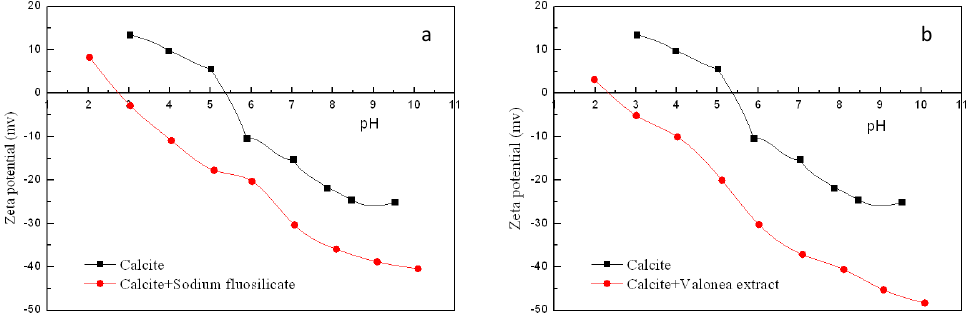
Figure 8. Effect of addition of sodium fluosilicate ( a ) and valonea extract ( b ) on the zeta potential of calcite (sodium fluosilicate dosage = 3 × 10 − 5 mol/L, valonea extract dosage = 4 × 10 − 4 g/L). a b